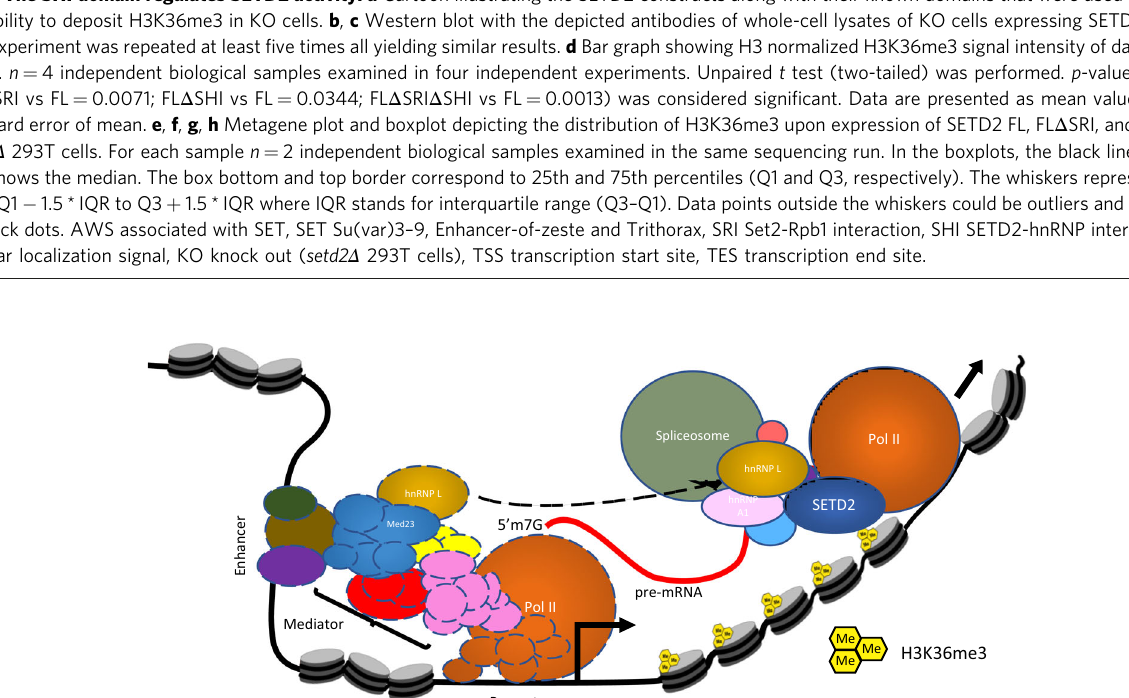
Fig. 8 Pre-mRNA processing and transcription are coupled. A cartoon speculating a possible mechanism of cross talk between hnRNP L and the transcription machinery. See text for